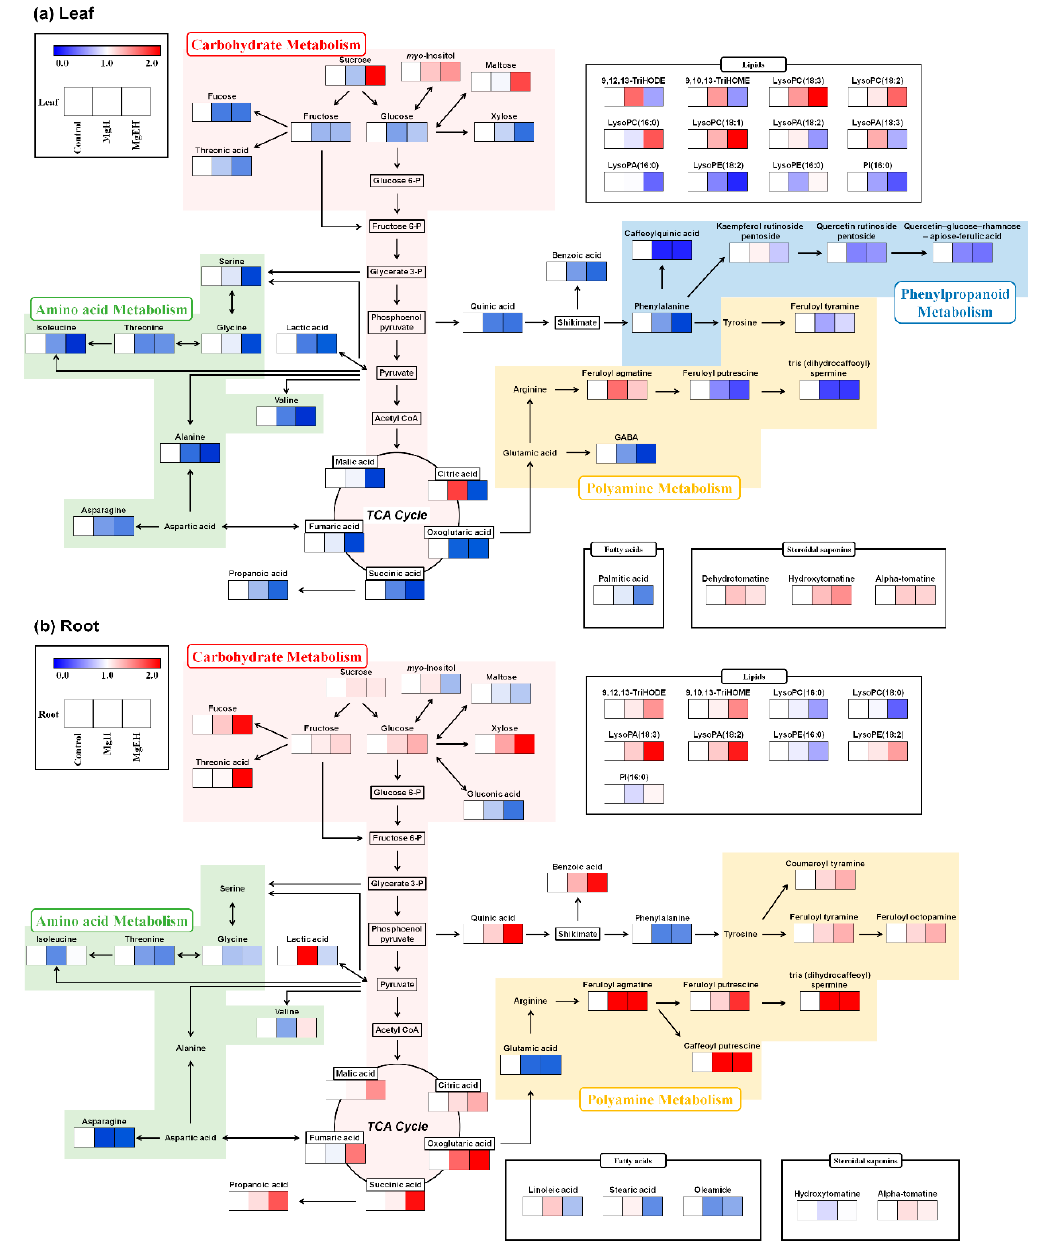
Figure 3. The constructed metabolic pathway for relative metabolite contents for tomato leaves ( a ) and roots ( b ) under Mg oversupply. The pathway was modified from the KEGG database (http://www.genome.jp/kegg/). The colored squares (blue-to-red) represent fold changes normalized by each metabolite level in the control